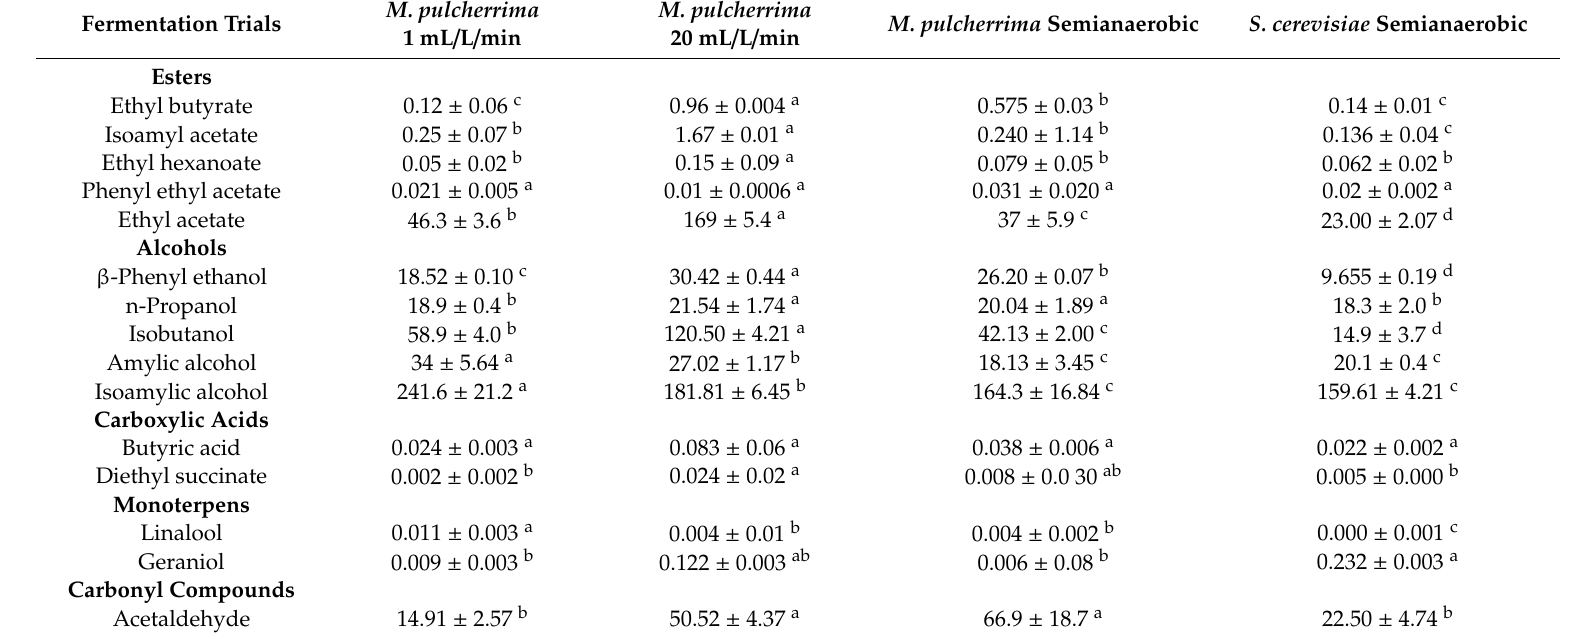
Table 3. Main volatile compounds of sequential fermentation with M. pulcherrima in di ff erent aeration conditions (mg /